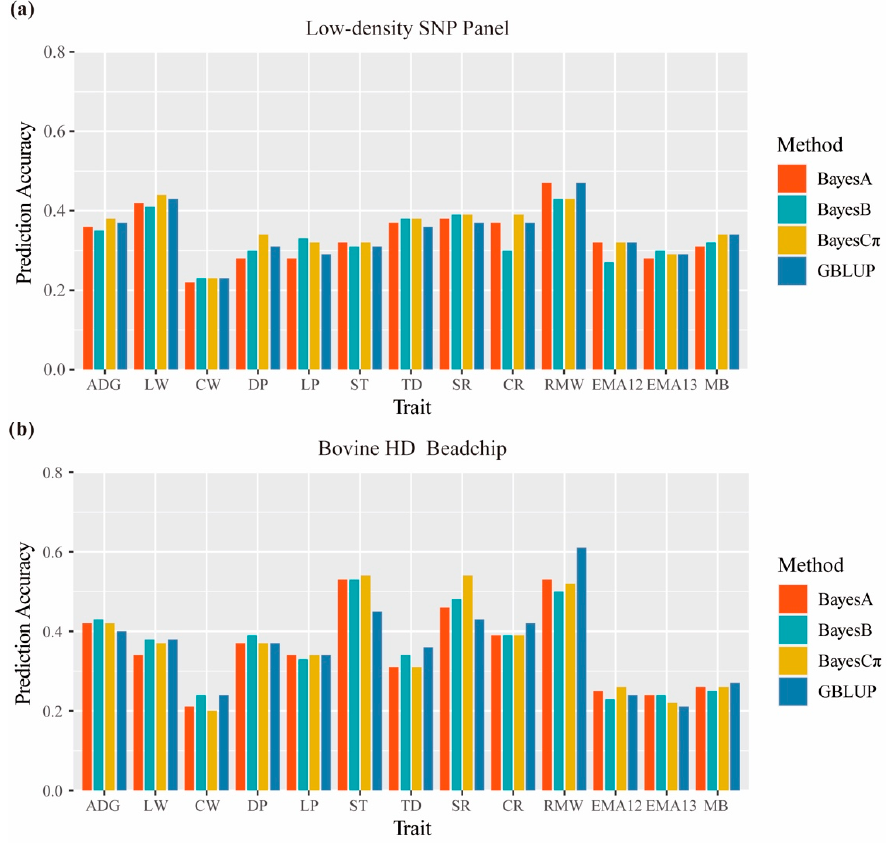
Figure 3. ( a ) The prediction accuracy of DGVs for the low-density SNP panel using BayesA, BayesB, BayesC π , and GBLUP methods. ( b ) The prediction accuracy of DGVs for the Illumina BovineHD using BayesA, BayesB, BayesC π , and GBLUP methods.